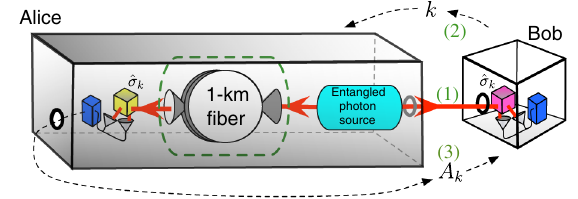
FIG. 1. Conceptual representation of the EPR-steering task. In each round of the protocol, Bob (1) receives a photonic qubit, (2) announces a measurement setting, k , and (3) receives a ‘‘measurement’’ result from Alice. See text for details. Bob must assume that Alice controls the source, her line, and her detectors (all enclosed in the gray box). Bob implements the measurement ^ (cid:1) k (pink cube) and monitors the measurement outcome (blue cube). In the case of an honest Alice, Bob’s qubit is half of an entangled pair and Alice’s measurement results are genuine; Alice measures in the same direction as Bob (yellow cube) using an identical apparatus. We demonstrate EPR- steering over 1 km of optical fiber inserted in the line on Alice’s side (green dashed